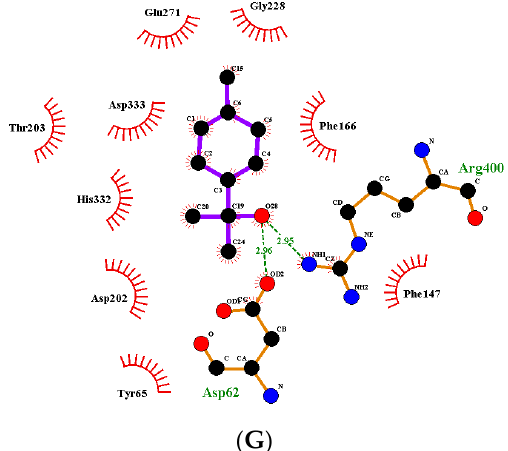
Figure 3. ( A ) Two-dimensional diagram of the interaction between α -glucosidase and linalool. ( B ) Two-dimensional diagram of the interaction between α -glucosidase and limonene. ( C ) Two-dimensional diagram of the interaction between α -glucosidase and (-)-terpinene-4-ol. ( D ) Two-dimensional diagram of the interaction between α -glucosidase and - β -pinene. ( E ) Two-dimensional diagram of the interaction between α -glucosidase and terpinene. ( F ) Two-dimensional diagram of the interaction between α -glucosidase and terpineol acetate. ( G ) Two-dimensional diagram of the interaction between α -glucosidase and α -terpineol.